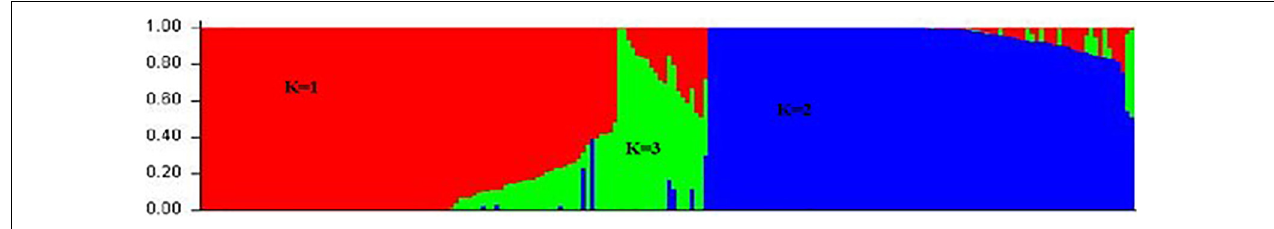
FIGURE 3 | Population structure of 206 common bean genotypes with 5,052 SNP markers, whereby red represents the Mesoamerican gene pool ( K = 1), blue represents the Andean gene pool ( K = 2), and green represents an admixture of the two pools ( K =